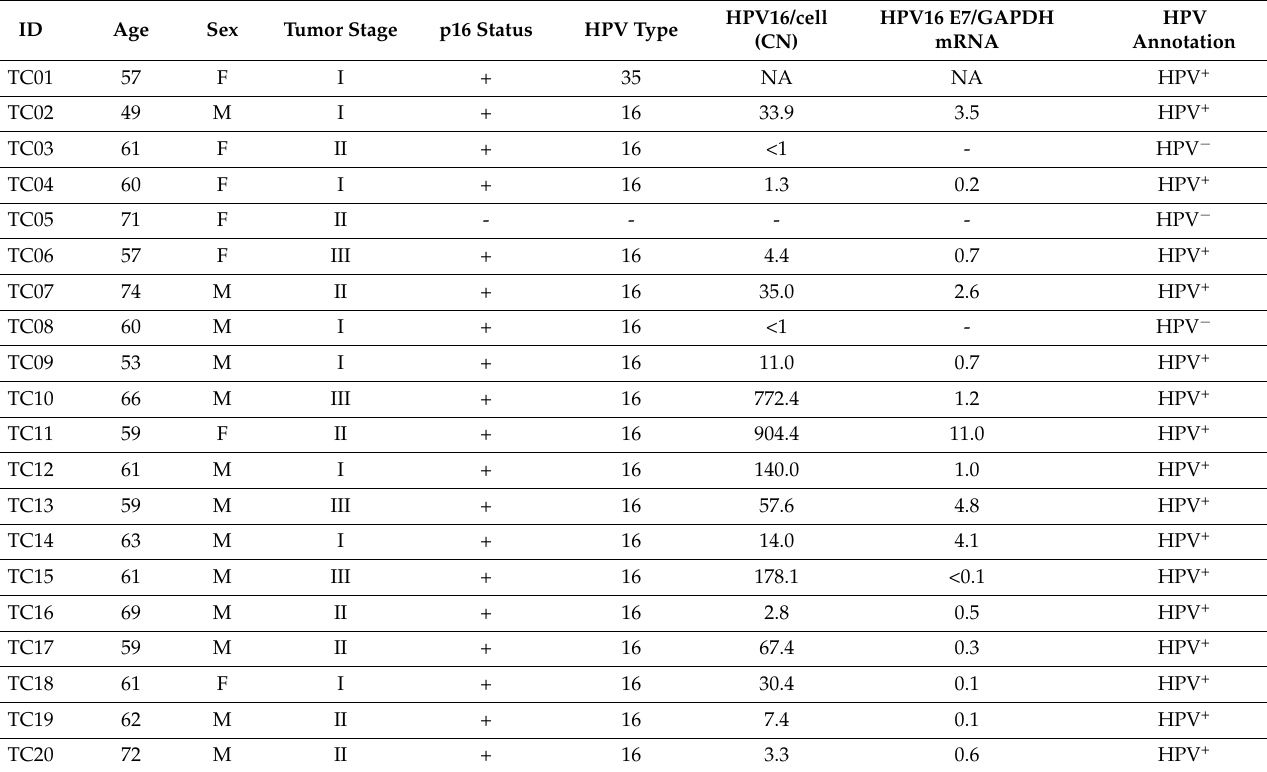
Table 1. Patient characteristics and HPV status in TC.